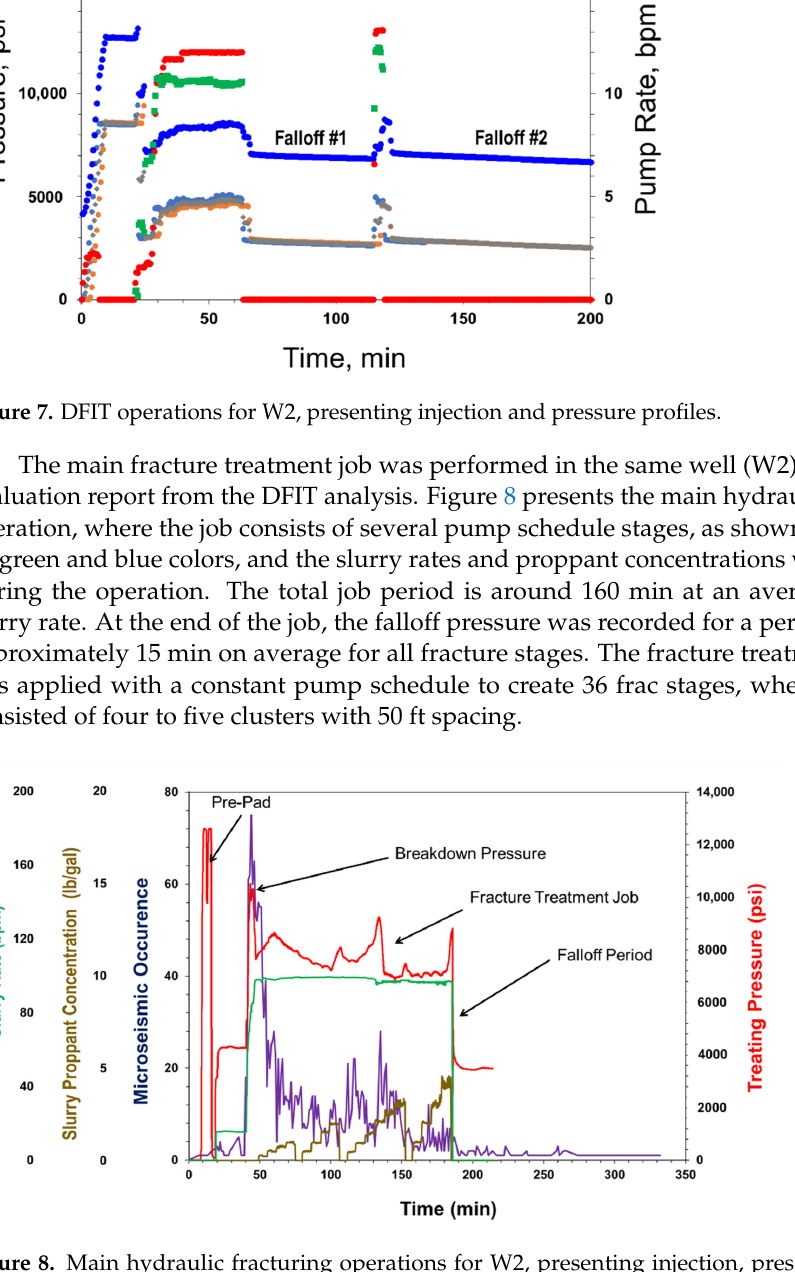
Figure 8. Main hydraulic fracturing operations for W2, presenting injection, pressure, proppant concentration profiles, and micro-seismic events.